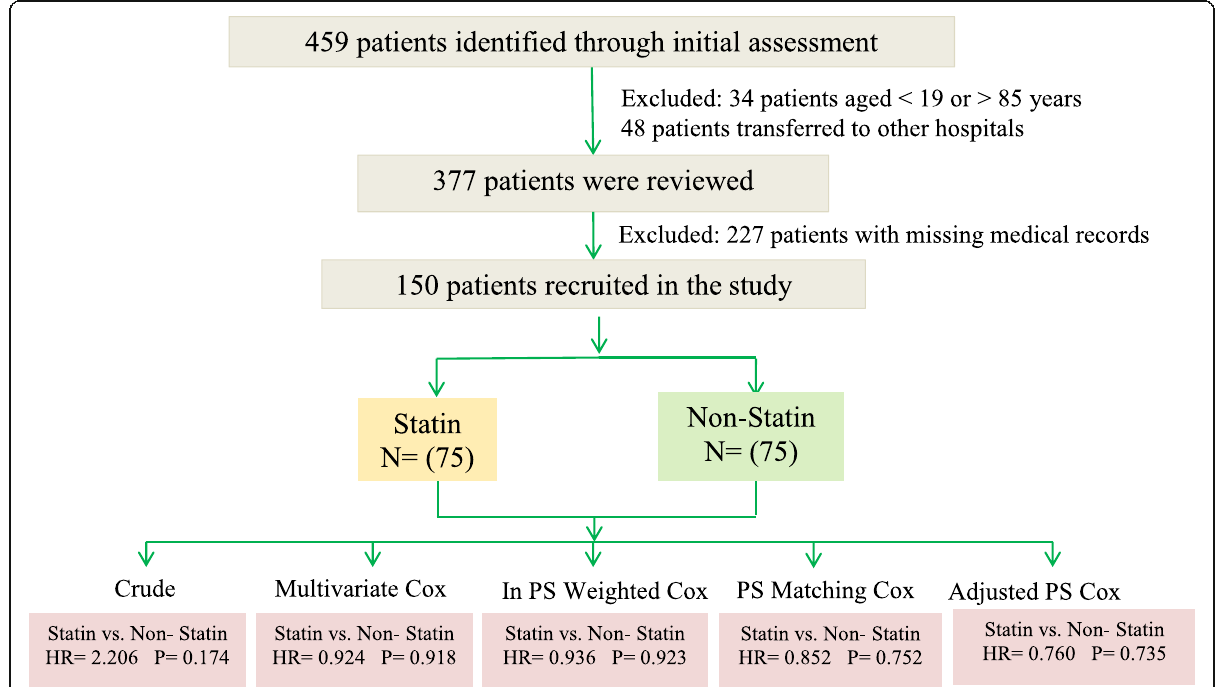
Fig. 1 Flow-chart of patient enrolment and summary of the inclusion and exclusion criteria. HR: Hazard Ratio; P: P-value; P S: Propensity Score; In PS: Invers Propensity